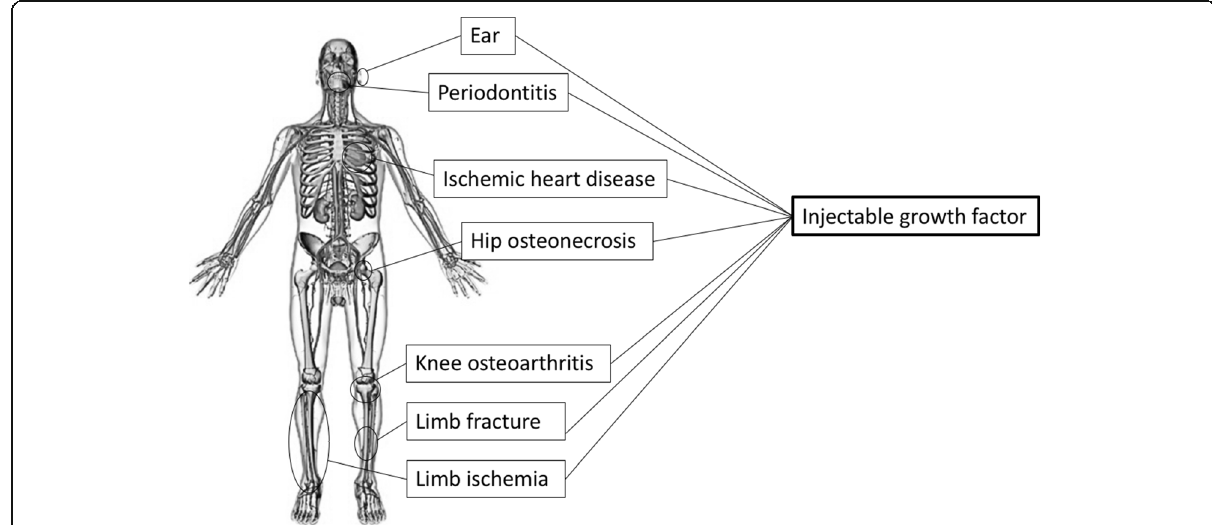
Fig. 1 Human figure showing where clinical applications of injectable growth factor are used. Injectable growth factor therapy is actually being performed from the head to